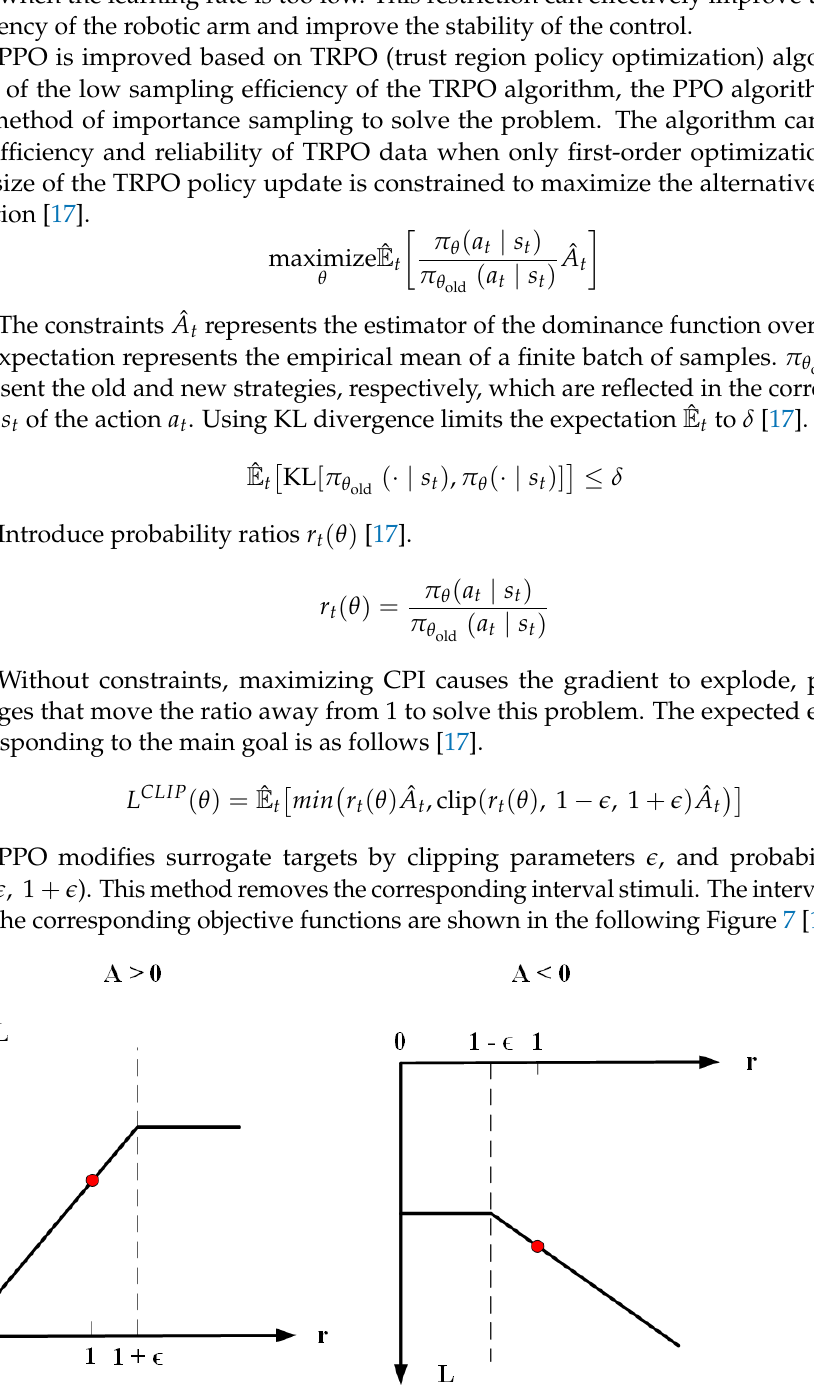
Figure 7. The objective function corresponding to the interval.